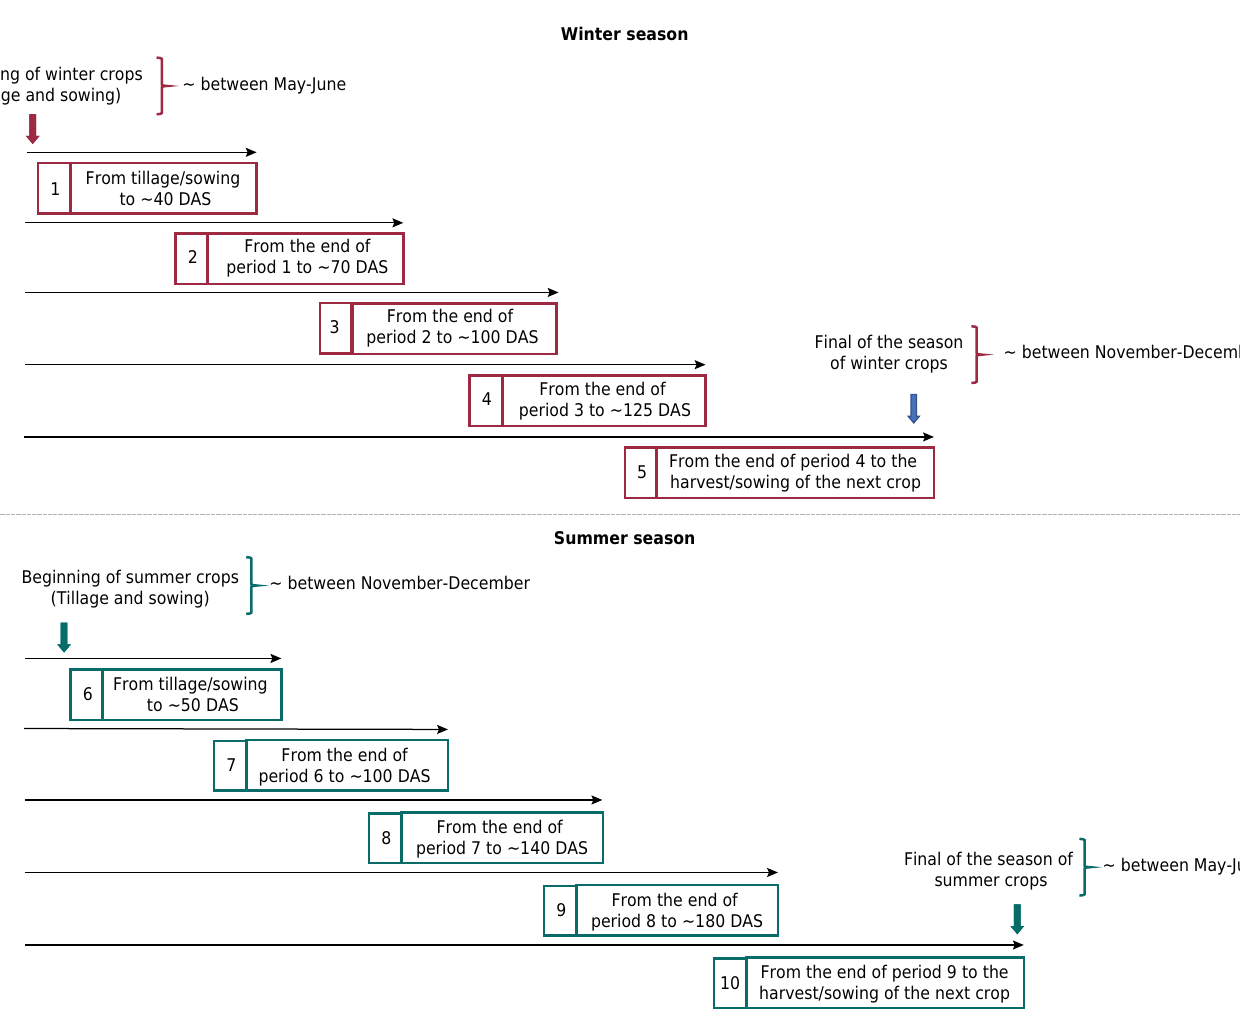
Figure 1. Timeline of the crop periods over the experiment. Periods between 1 and 5 corresponding to winter crops; periods between 6 and 10 corresponding to summer crops. Note that the initial and final periods was not exactly the same over the 13 years of experimentation, but it was in a narrow variation of months. DAS: days after